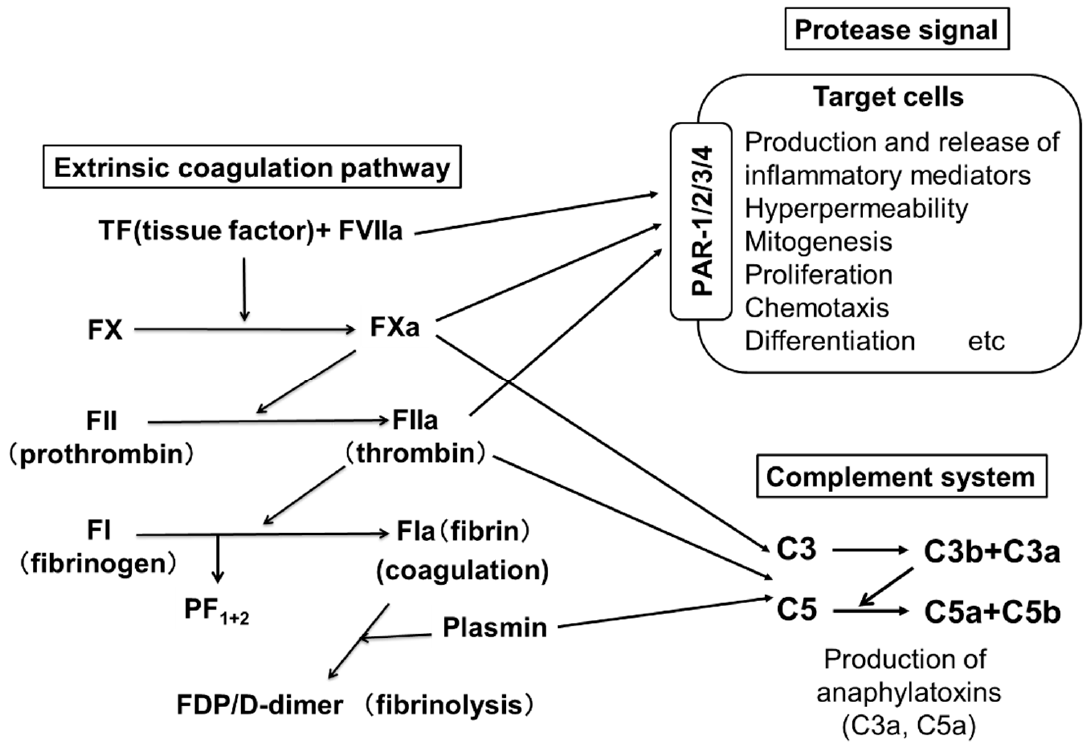
Figure 2. The extrinsic coagulation pathway and activation of PARs and complements by active form of coagulation factors. PARs, C3aR and C5aR are expressed on the surfaces of skin mast cells and peripheral basophils. Since FVIIa, FXa, FIIa and plasmin are serine proteases, FVIIa activates target cells via PAR-2. FXa and FIIa activate various types of cells via PAR-1,2,3 and PAR 1,3,4, respectively. Fibrin is also able to promote an inflammatory response via Toll-like receptor (TLR)-4. Moreover, activated coagulation factors (FXa and FIIa) produce C5a and C5b from C5, and C3a and C3b from C3.